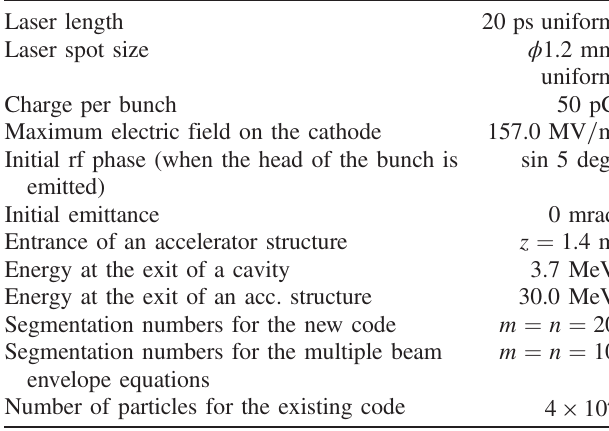
TABLE II. Parameters for calculations of beam dynamics in the SPring-8 rf gun injector system with focusing